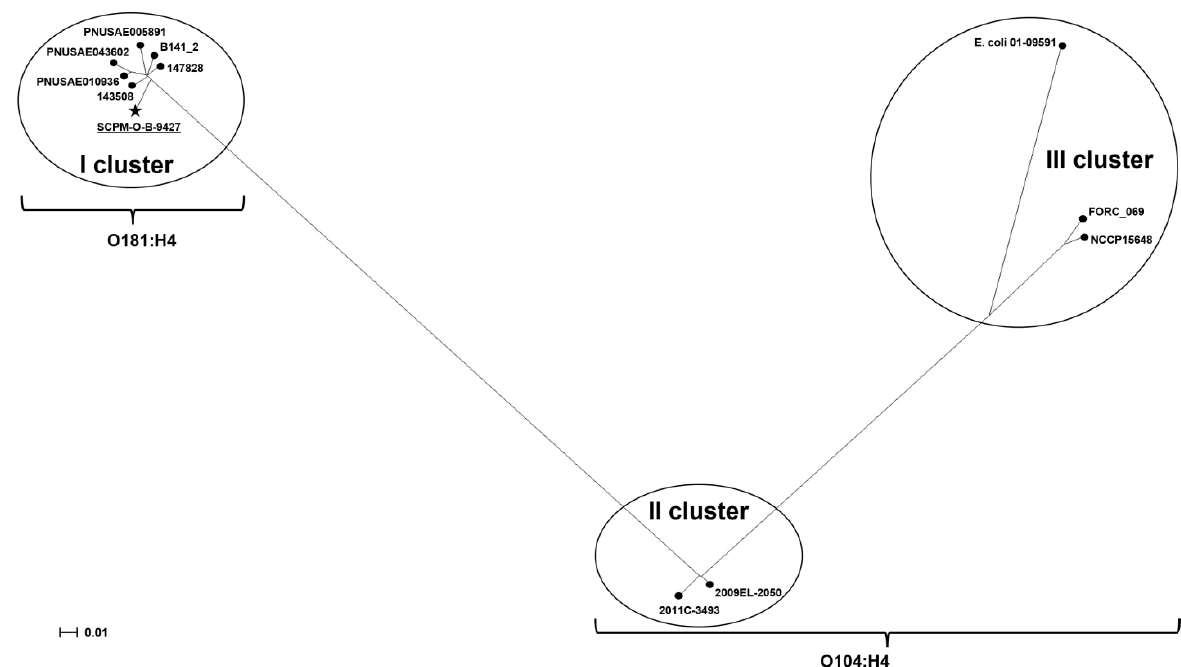
Figure 6. Neighbor-joining phylogenetic tree based on core SNPs, showing the phylogenetic relationship between chromosomes of EAHEC strain SCPM-O-B-9427 and E. coli O104:H4 and E. coli O181:H4 strains. The scale bar shows the expected number of substitutions per site. Bar, 0.01 substitutions per nucleotide position.